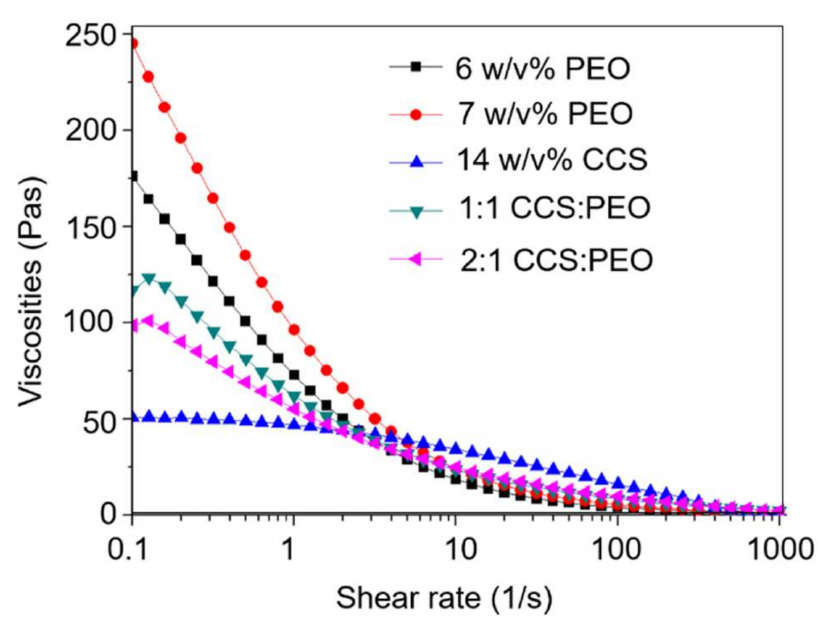
Figure 4. Dynamic viscosity of the different solutions via a rheometer.